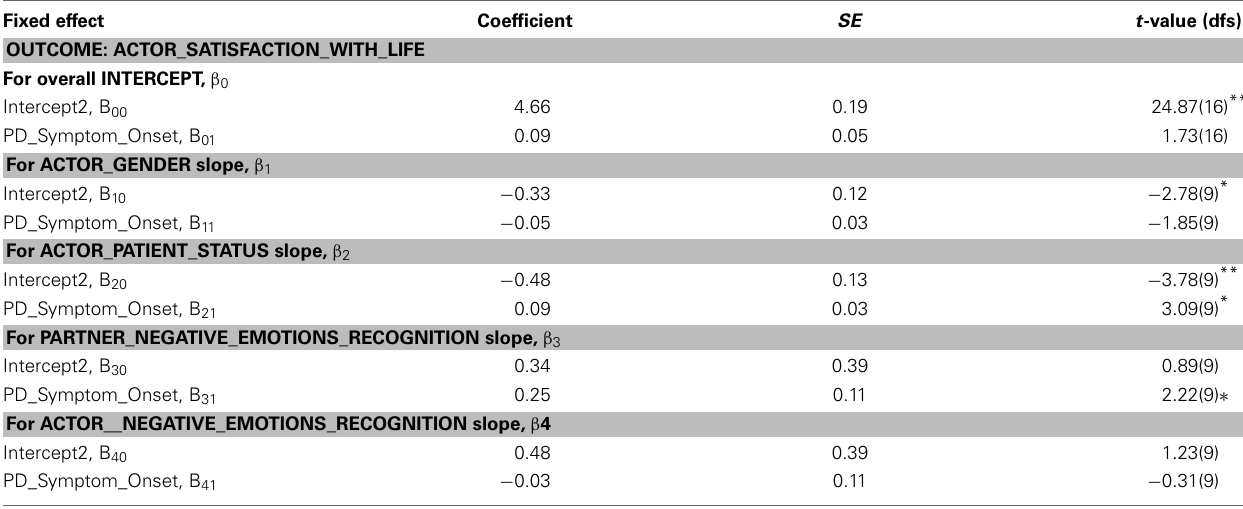
Table 5 | Parameter estimates for the HLM analyses predicting an actor’s hedonic balance and life satisfaction from his/her partner’s proficiency in identifying negative emotions in Study 2.